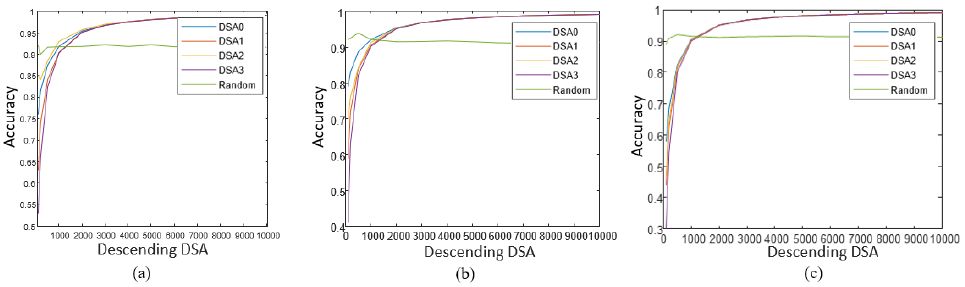
Figure 6. Testing accuracy variation as the descending DSA. ( a ) Layer1. ( b ) Layer2. ( c ) Layer3.